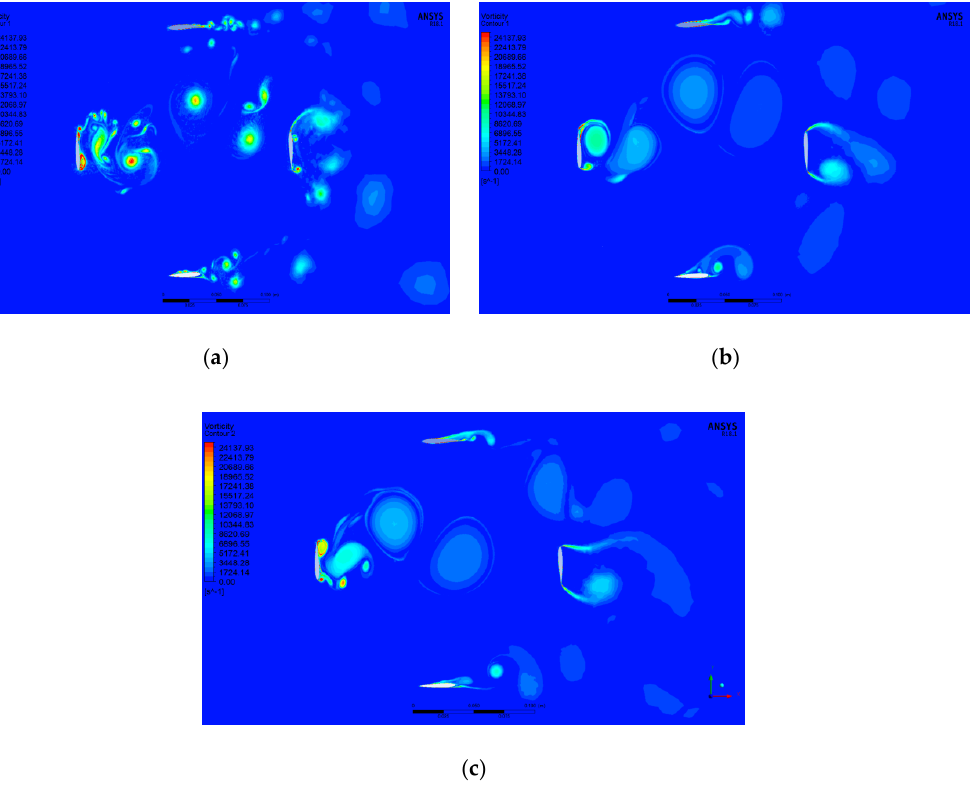
Figure 10. Contours of vorticity for DDES ( a ), RANS Transition ( b ) and RANS SST k-ω ( c ) at 0° azimuthal position at λ max = 0.29.